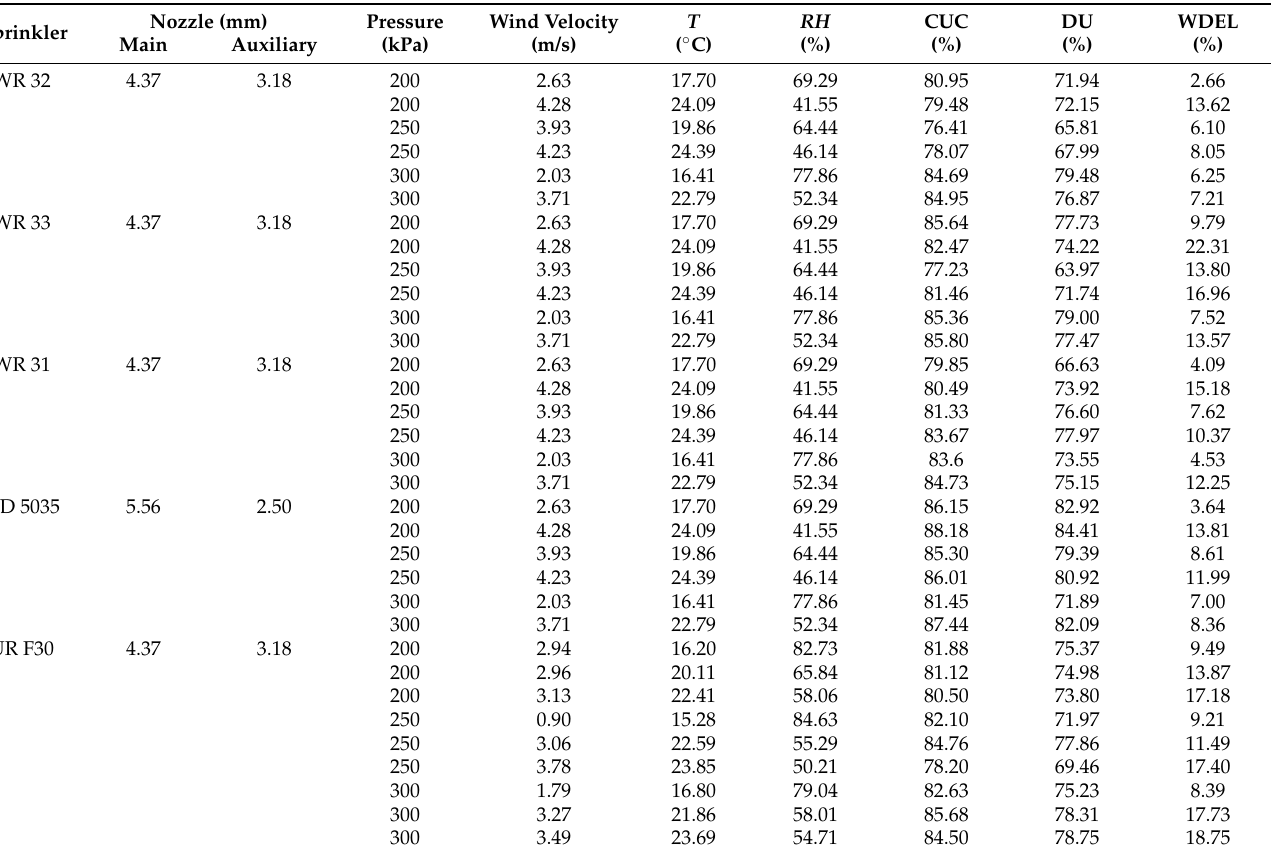
Table A1. Irrigation performance and experimental conditions for all sprinkler